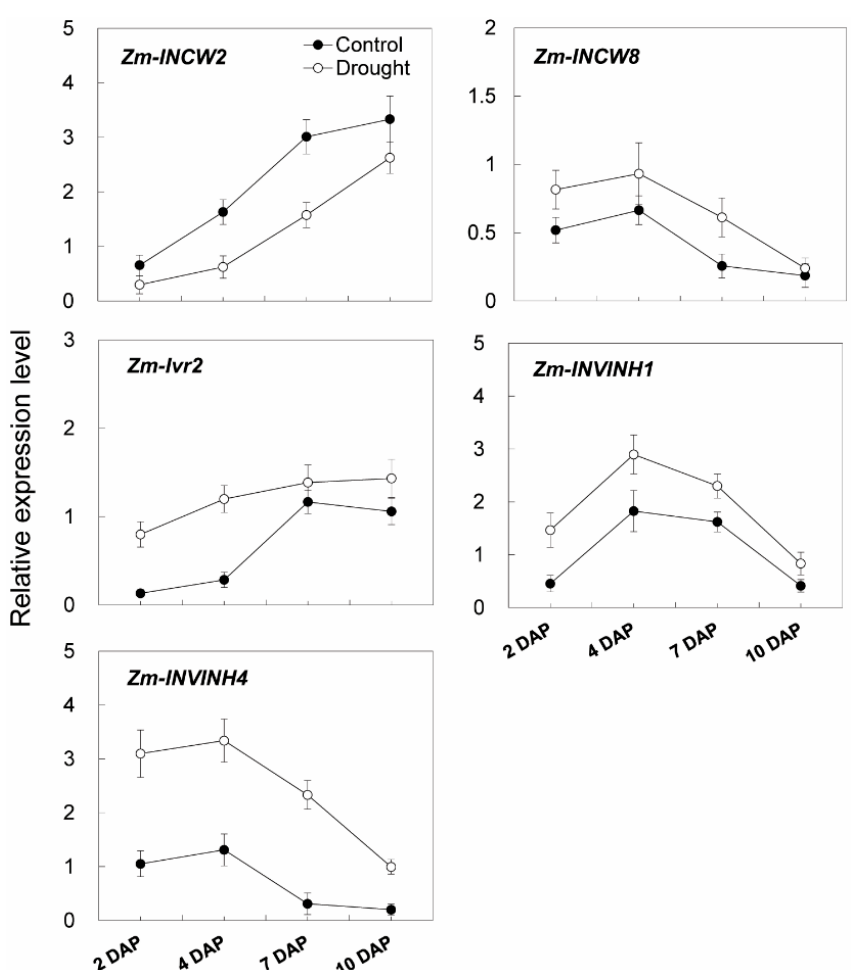
Figure 13. Relative expression of invertase and invertase inhibitor related genes in young maize kernels during drought stress. Gene expression levels were determined by quantitative real-time PCR and were normalized against the maize actin and ubiquitin genes. Data represents mean ± SE of at least three independent biological replicates.